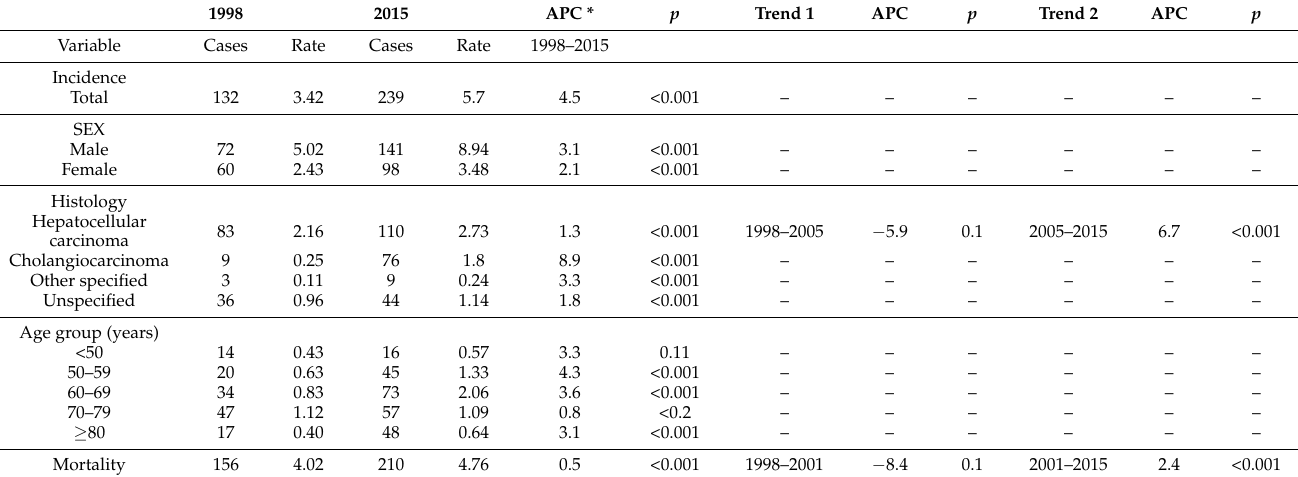
Table 2. Changes in age-standardized primary liver cancer incidence and mortality in Lithuania between 1998 to